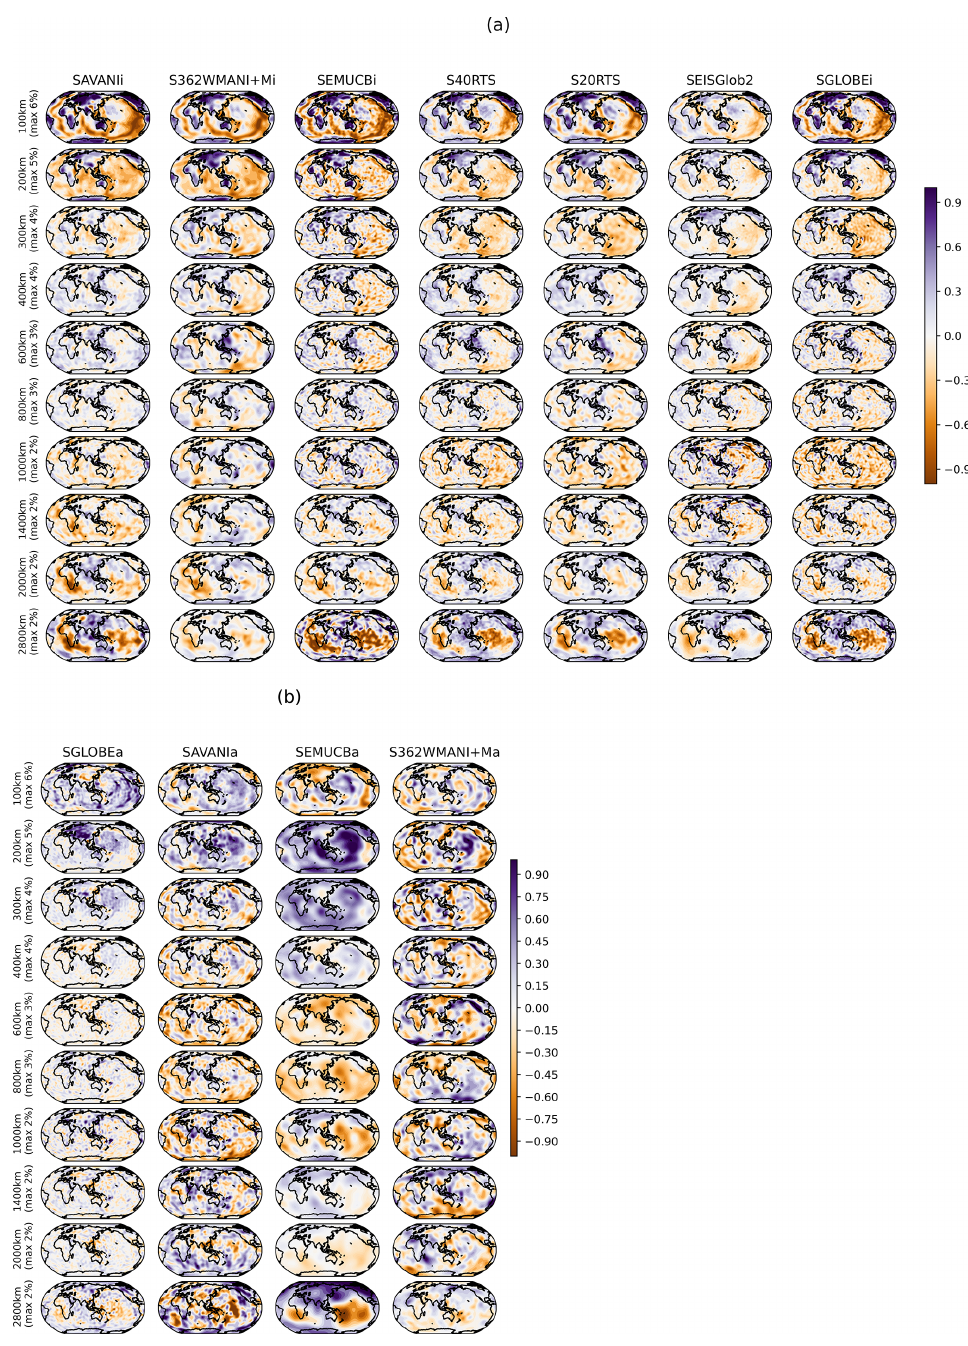
Figure A1. Depth slices of the isotropic and anisotropic models used in this study at the depths of 100, 200, 300, 400, 600, 800, 1000, 1400, 2000 and 2900km. The isotropic (a) and anisotropic (b) models show perturbations in shear-wave speed and in ξ = V 2 PREM (Dziewonski and Anderson, 1981), respectively. The colour scale is normalised to vary from − max to + max, with the range of model amplitude variations shown at the left of each row. For simplicity, in the remainder of this paper we add the letter “i” to the tomography models’ names when referring to their isotropic part and we add the letter “a” when referring to their radially anisotropic part; in the different figures “SGLOBE” will stand for SGLOBE-rani and “SEMUCB” for SEMUCB-WM1.